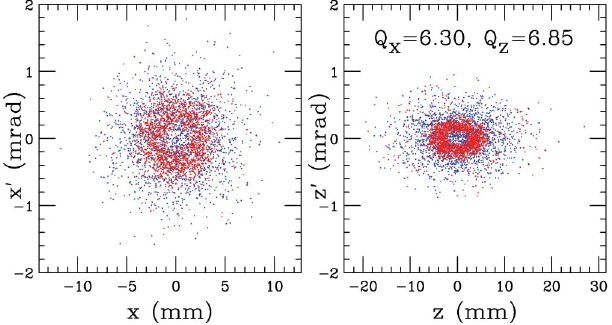
FIG. 33. (Color) The horizontal (left plot) and vertical (right plot) phase-space distributions for a beam with 12-turn injection for skew-quadrupole amplitude 0 : 0014 m (cid:1) 1 . The initial phase- space points, shown in blue dots, have normalized emittances of about 1 : 7 (cid:7) mm mrad on both planes. The final phase-space distributions, shown in red at 6000 revolution, have normalized emittances 2.6 and 3 : 8 (cid:7) mm mrad in the horizontal and vertical planes, respectively. Note that the phase-space distribution be- comes hollow in both the horizontal and vertical planes.